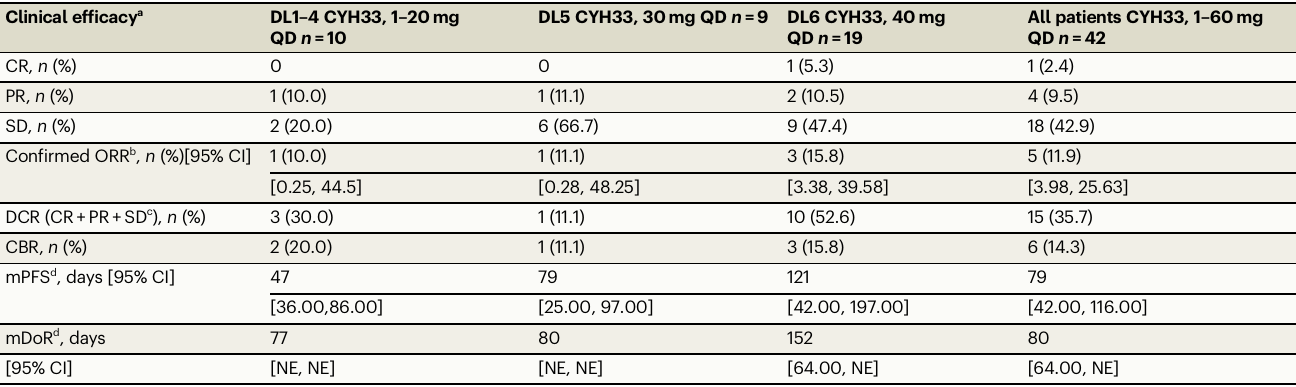
Table 4 | Summary of clinical ef fi cacy in evaluable analysis set Clinical ef fi cacy a